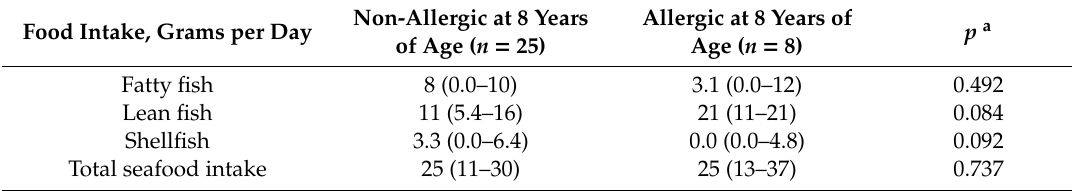
Table 5. Maternal intake of fish during pregnancy in relation to allergy diagnosis at 8 years of